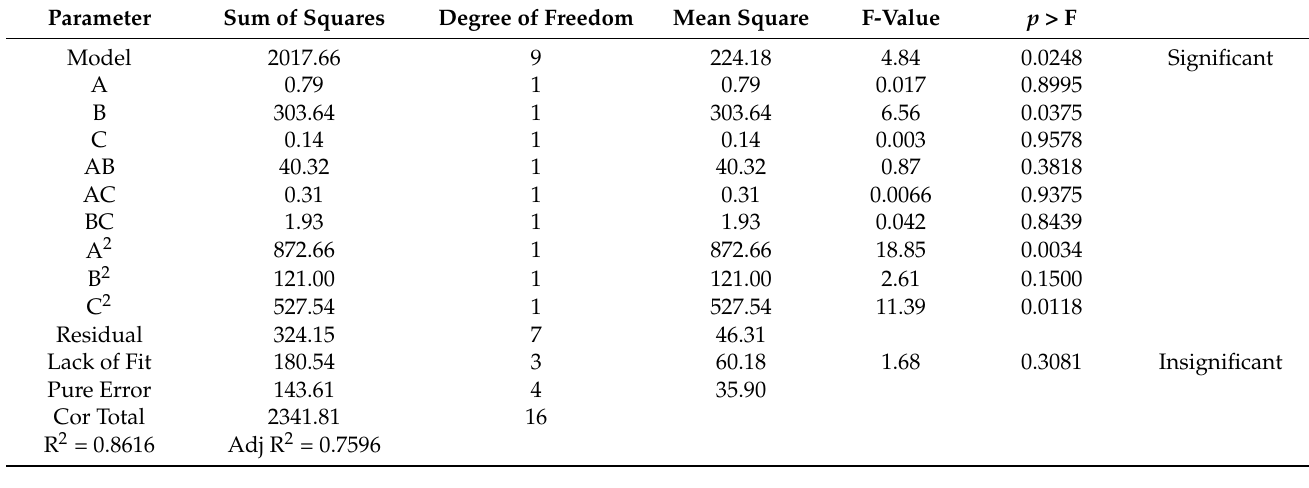
Table 4. ANOVA analysis of the quadratic model.